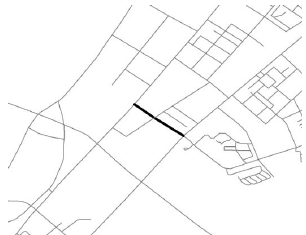
Figure 4. The location of road (ID: 2057) in road